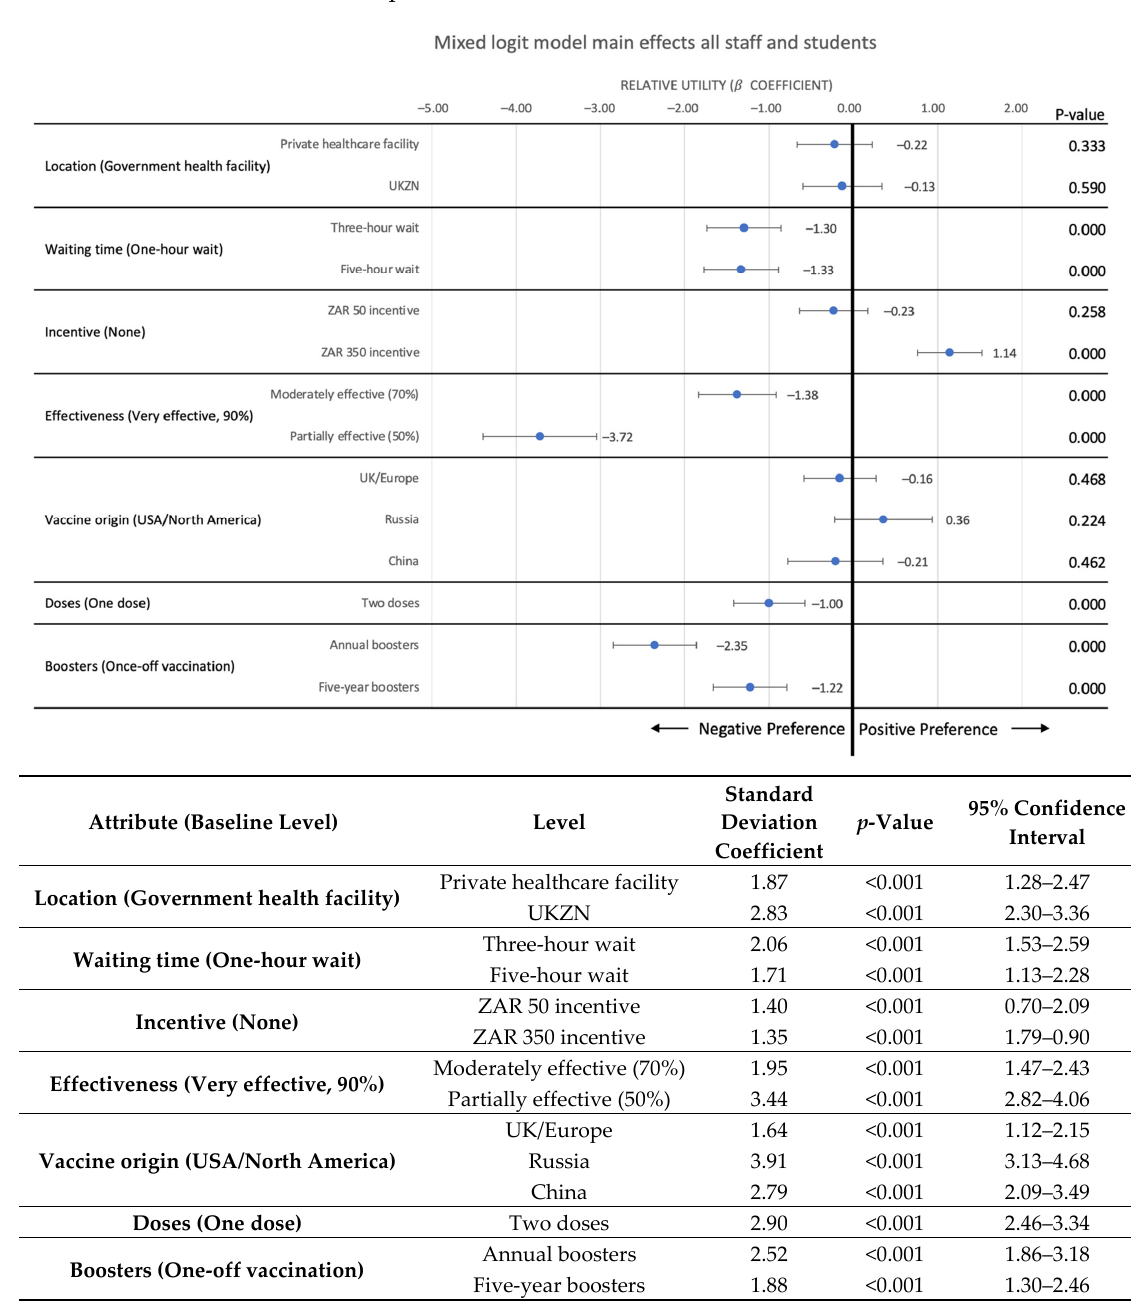
Figure 1. Main effects mixed effects logit model results—mean relative utility estimates and standard deviations. Notes: The point estimates show the mean relative utility (or beta coefficients) for each attribute level, and the error bars show the 95% confidence interval for each attribute level, relative to the baseline level for each attribute (shown in brackets on the left). Positive utilities represent what participants prefer, and negative utilities represent what participants do not prefer. The table on the right-hand side of the figure shows the standard deviation coefficients and p -values, which indicates where preference heterogeneity exists within the sample. Significant p -values indicate significant heterogeneity, which should be further explored to understand more clearly why preferences diverge, and which key sample sub-groups have specific preferences for particular